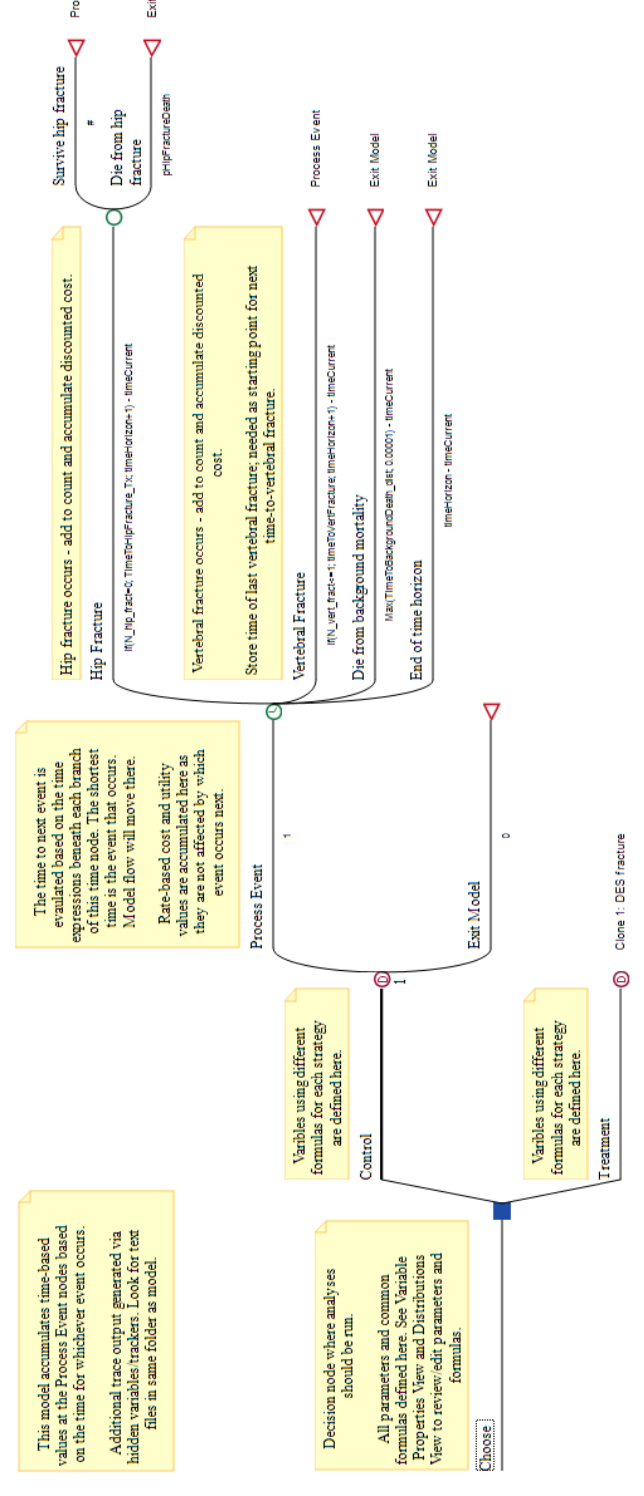
Figure A9. Decision tree for the osteoporosis model in TreeAge. The decision has one subtree for each intervention (here, ‘Control’ and ‘Treatment’). The subtrees perform the DES simulation, as noted by their root being a DES node (circled ‘D’). The top DES node is labelled with ‘1’ because it was the source for cloning the bottom one. Branches in a DES subtree may have a time to event or a probability value; in this case, a ‘#’ symbol represents the complement